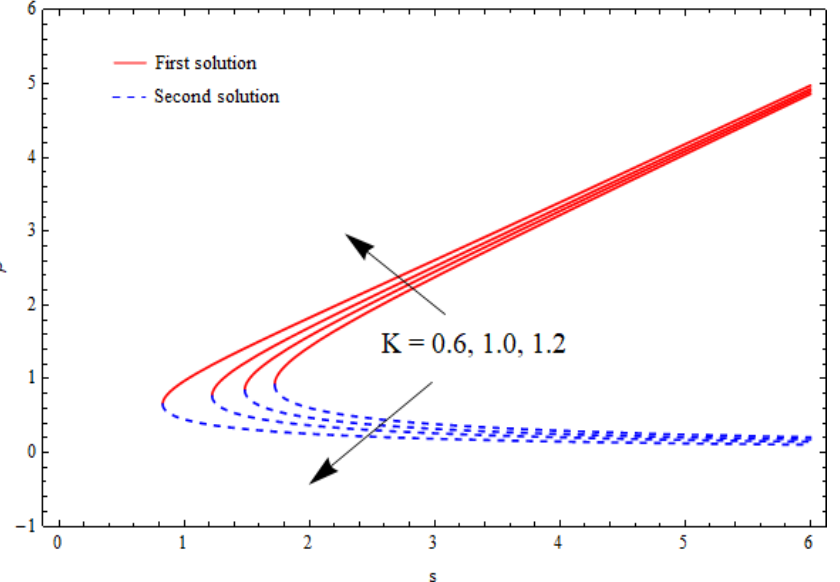
Figure 2. The solution domain β against mass suction parameter s for distinct k 1 when λ = − 1.5, γ = 1, δ = − 1, ϕ 1 = 0.1 = ϕ 2 .